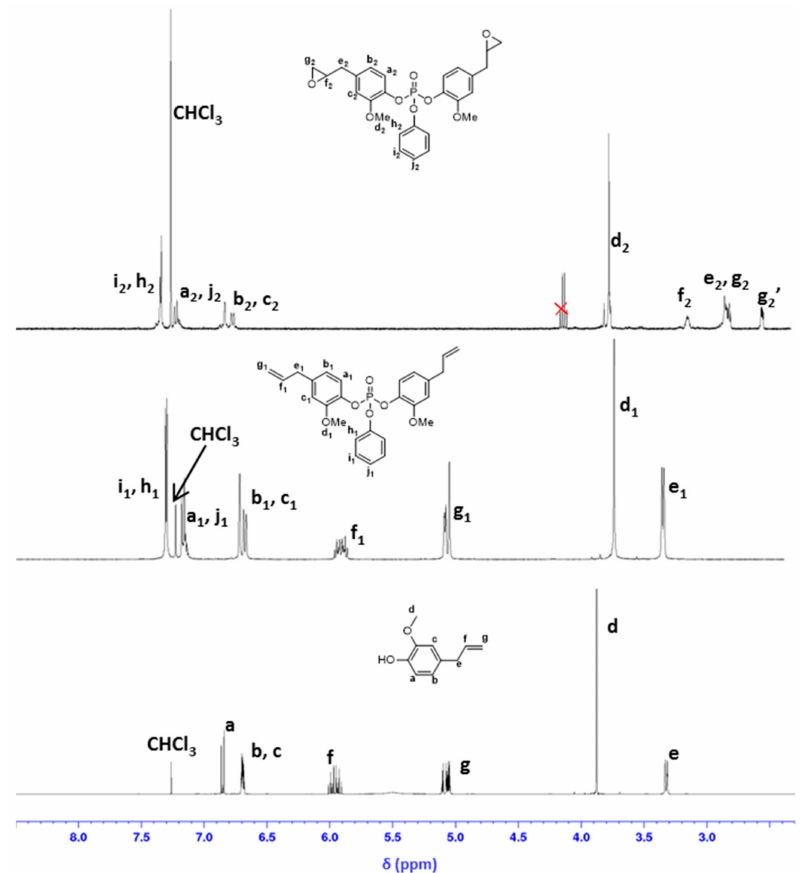
Figure 1. Stacked 1 H NMR spectra of: Eugenol (bottom), DEP (middle) and DEEP (top) in CDCl 3